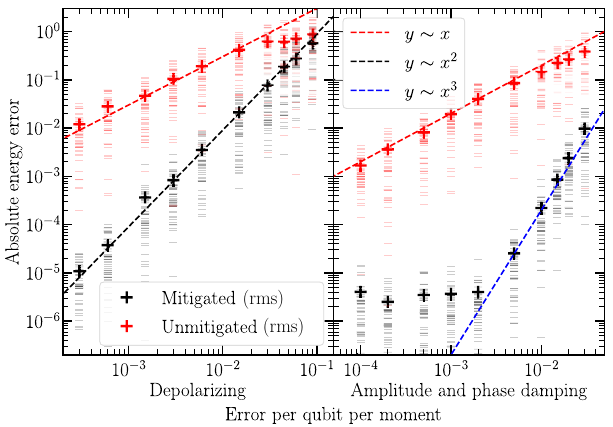
FIG. 3. Mitigation of a four-qubit Givens rotation circuit via verified phase estimation. Left: error in estimation of random states in a free-fermion system [Eq. (56)] under a uniform depo- larizing channel. Right: error in the same estimation, but this time under an amplitude and phase damping model. In both plots, the RMS error (crosses) is calculated over 50 different estimations for each error rate using either standard partial state tomography (red) or using verified control-free phase estimation. Individ- ual data points (dashes) are additionally shown. For reference, dashed lines showing linear (red), quadratic (black), and cubic (blue) dependence on the gate error rate are